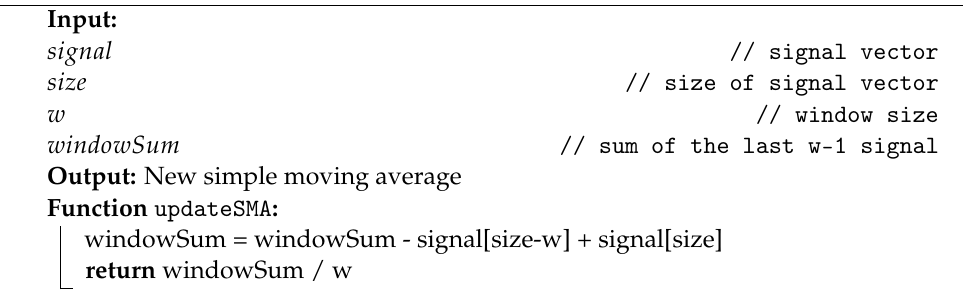
Algorithm 1: Instructions for updating the SMA.